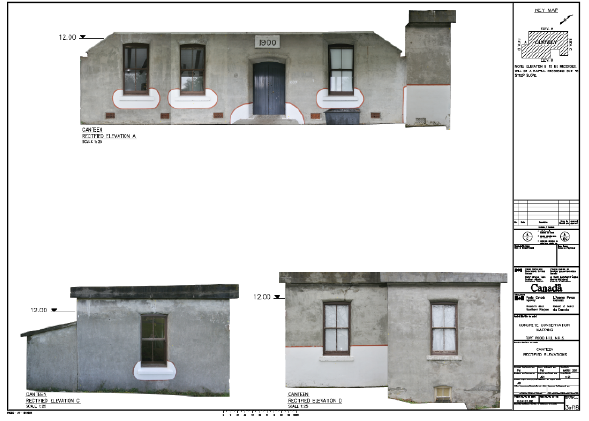
Figure 3: Example of orthographic elevations with designated repairs.